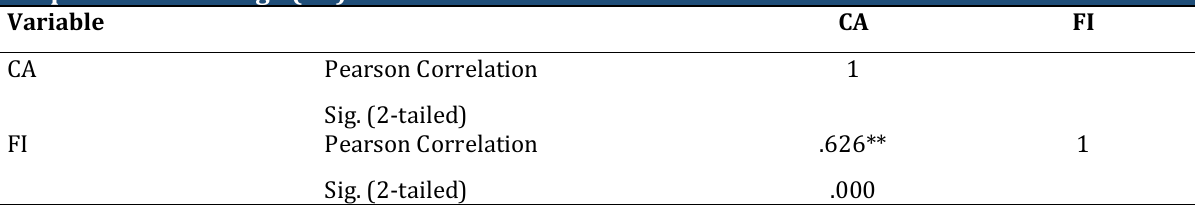
Table 3: Pearson product-moment correlations between functional integration (FI) & competitive advantage